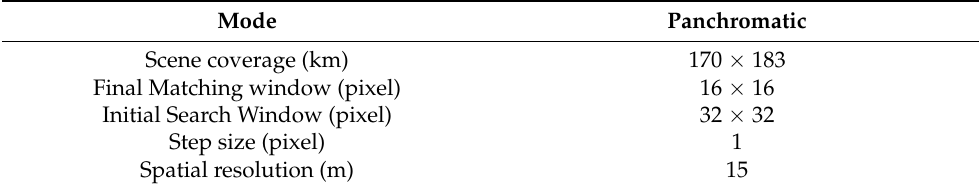
Table 1. Specifications and processing parameters of Landsat 8